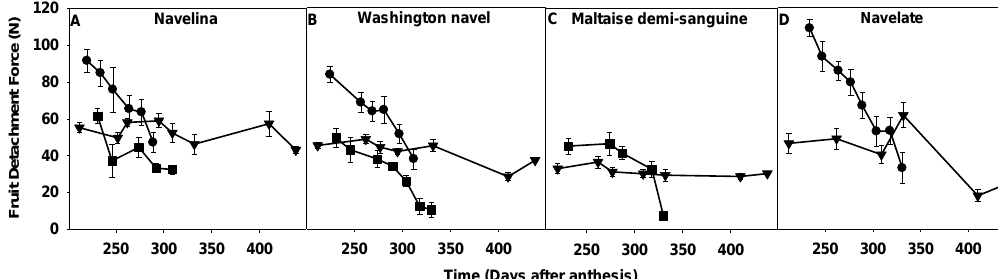
Figure 1. FDF kinetics during fruit maturation in Corsica ( ▼ ) , Spain ( ● ) and Tunisia ( ■ ). FDF was measured in ( A ) ‘Navelina’, ( B ) ‘Washington navel’, ( C ) ‘Maltaise demi-sanguine’ and ( D ) ‘Navelate’. Values are means ± SE ( n = 12). Anthesis occurred in the first, second and fourth week of April 2012 in Tunisia, Spain and Corsica, respectively. In the graphs, day 150 after anthesis thus corresponds to 09 / 26 / 2012 in Corsica, 09 / 12 / 2012 in Spain, and 09 / 07 / 2012 in Tunisia.